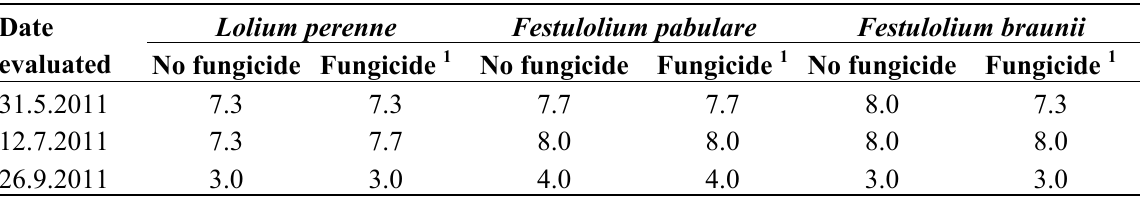
Table 1. Level of infection in Lolium perenne , Festulolium pabulare , and Festulolium braunii before and after first fungicide application (on scale of 1 (highest infection) to 9 (lowest